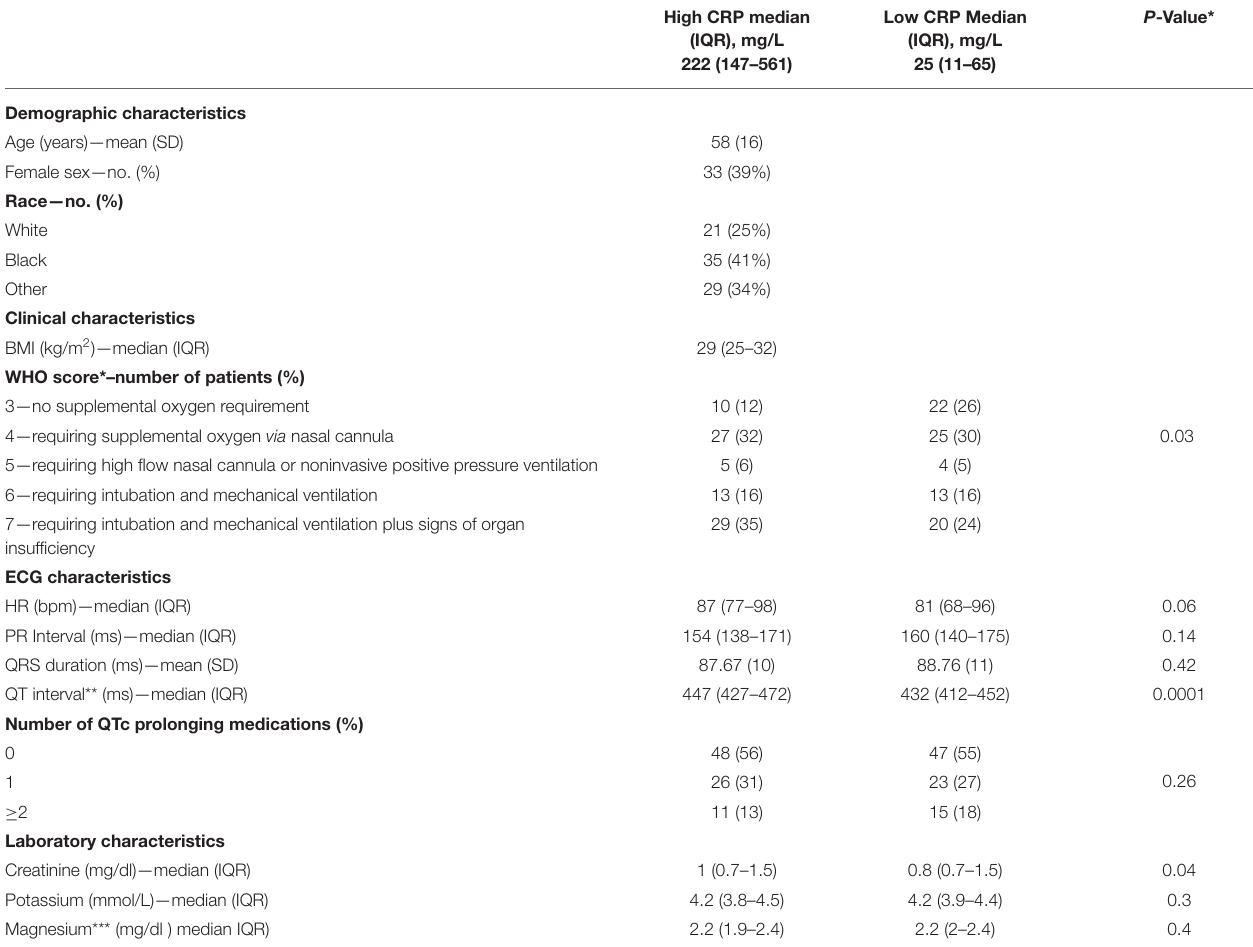
TABLE 1 | Baseline demographic and clinical characteristics by high and low CRP days, n =